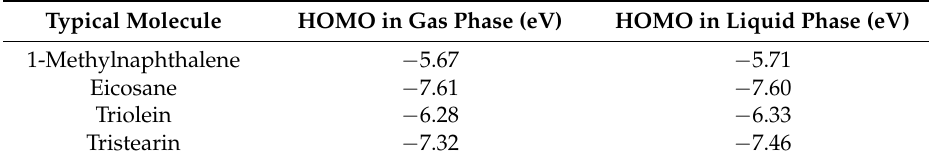
Table 4. Highest occupied molecular orbital (HOMO) energies of typical molecules.